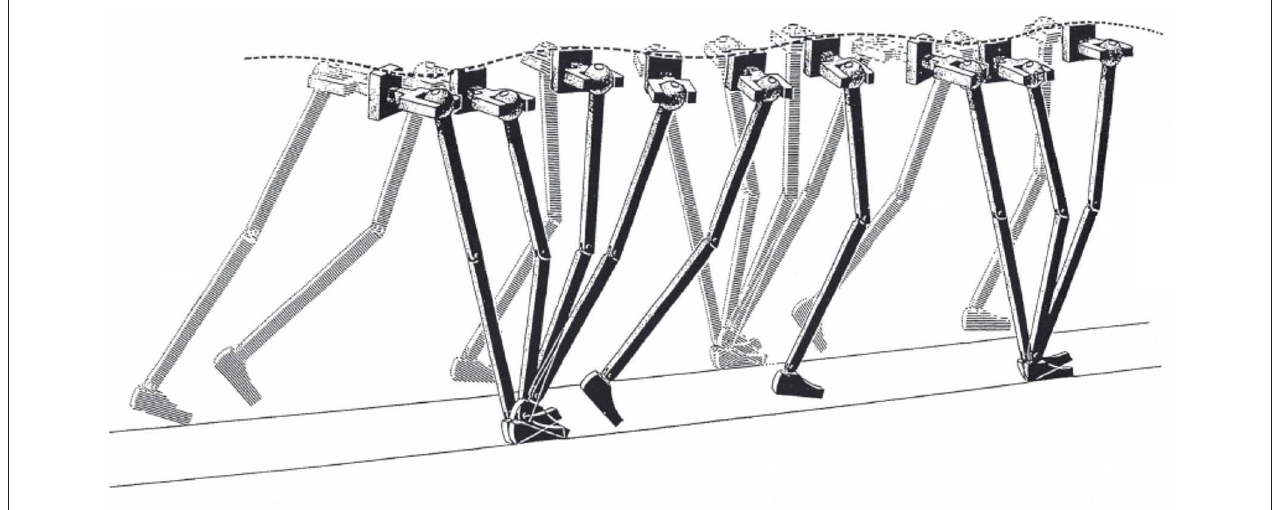
FIGURE 1 | Illustration of the “inverted pendulum” model of walking. Some of the sagittal, frontal, and horizontal rotations of the joints are seen as major determinants of gait, as long as they usefully smooth the trajectory of the body center of mass. Taken from Saunders et al. ( 19), used with